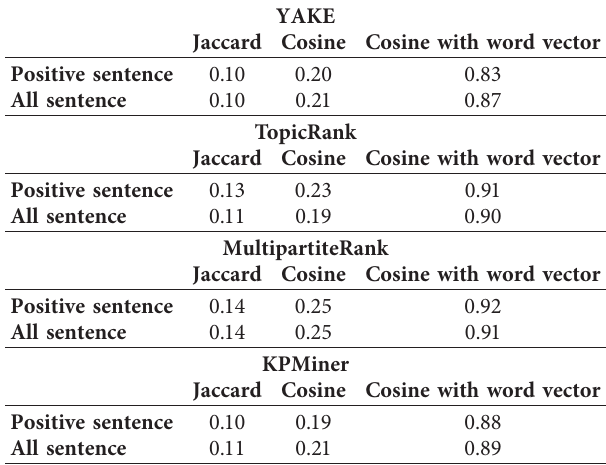
Table 3: Similarity scores calculated for different supervised keyword extraction techniques.